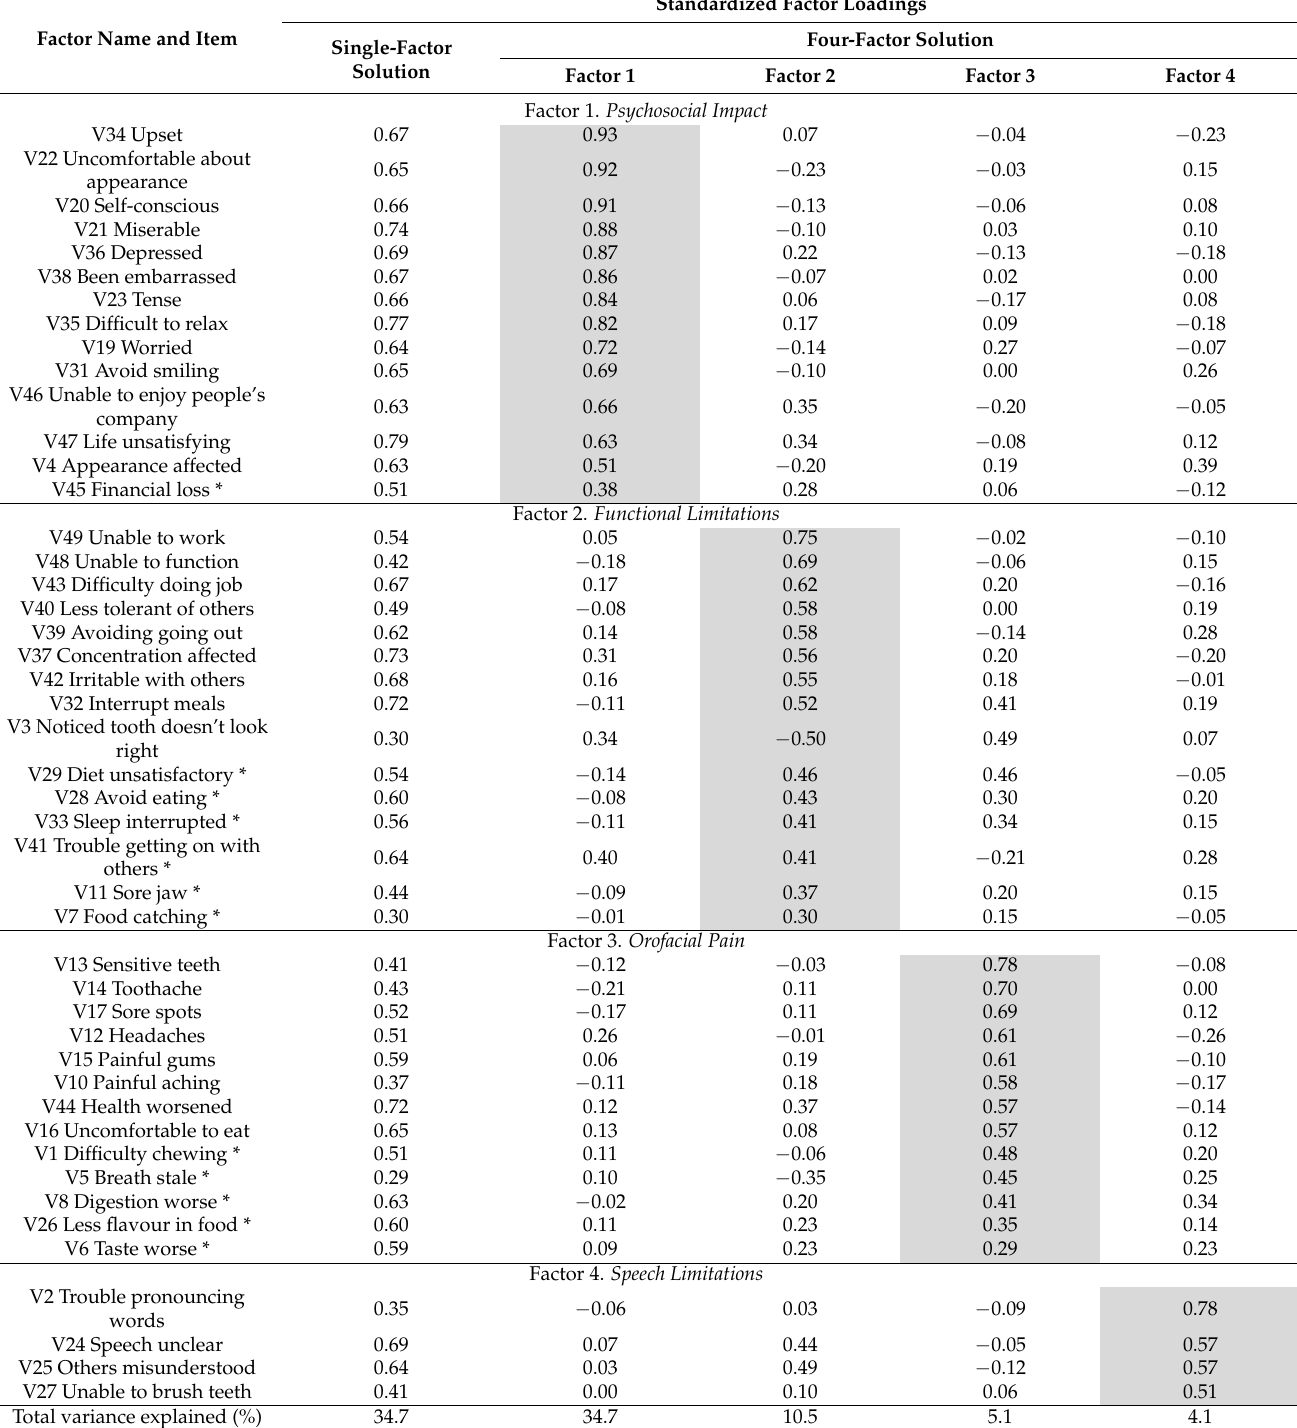
Table 2. Results of exploratory factor analysis: factor loadings in the single-factor solution and four-factor solution for 46 items of the